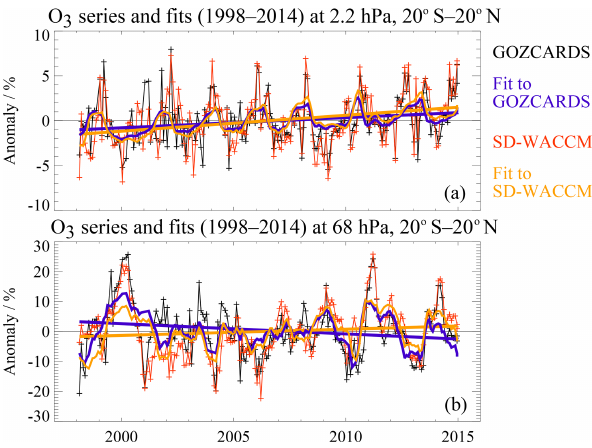
Figure A3. Deseasonalized monthly mean anomaly time series for O 3 (%) at 2.2hPa (a) and 68hPa (b) , for 1998 through 2014, for av- erages over 20 ◦ S–20 ◦ N. Note that the y axis range for 68hPa (b) is 3 times larger than for 2.2hPa (a) . The data set (black) is from the GOZCARDS ozone record, with the SD-WACCM (simulated) series (red) also shown. Fits to the observational series are in pur- ple, and fits to the model series are in orange; the fitted time series functions (curves) and the fitted linear components (straight lines) are